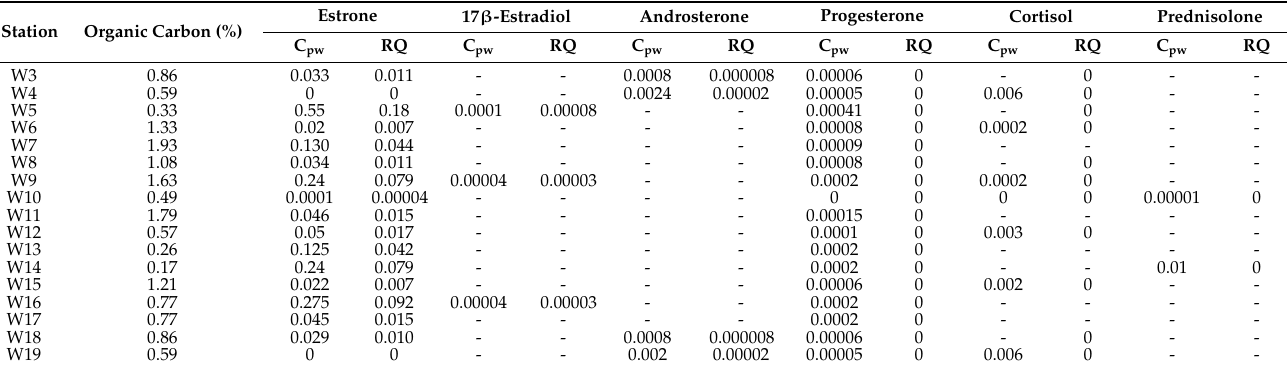
Table 3. RQ values of target steroids in marine